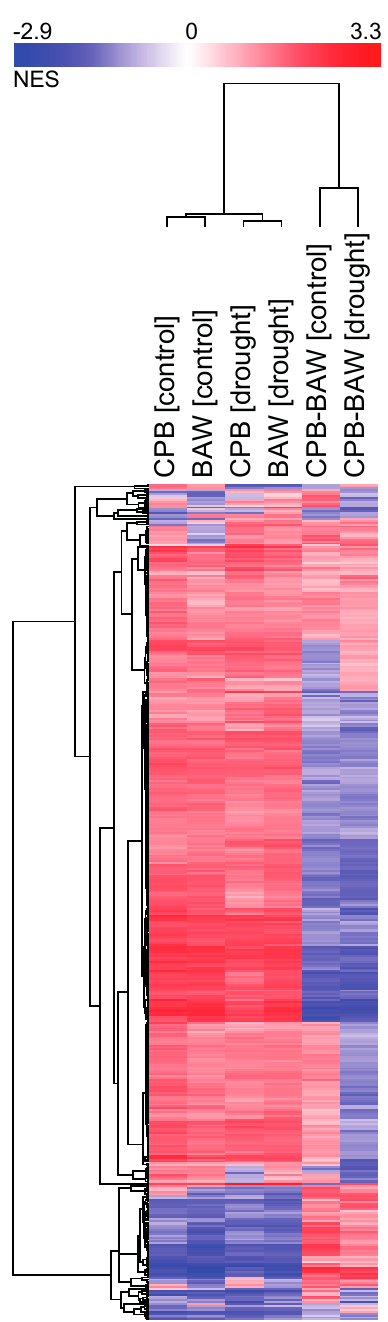
Figure 5. Hierarchical clustering of the normalized enrichment scores (NES) of biological processes (BPs) responding to insect herbivory in Solanum dulcamara plants. Each column is a pairwise comparison between two conditions to show the effects of herbivory by Spodoptera exigua or Leptinotarsa decemlineata under well-watering conditions (BAW (control) and CPB (control), respectively) or drought treatment (BAW (drought) and CPB (drought), respectively), or to show differences between herbivory treatments by the two insects on well-watered (CPB-BAW (control)) or drought-stressed plants (CPB-BAW (drought)). Colours indicate directions of enrichment: red for upregulation (positive NES) and blue for downregulation (negative